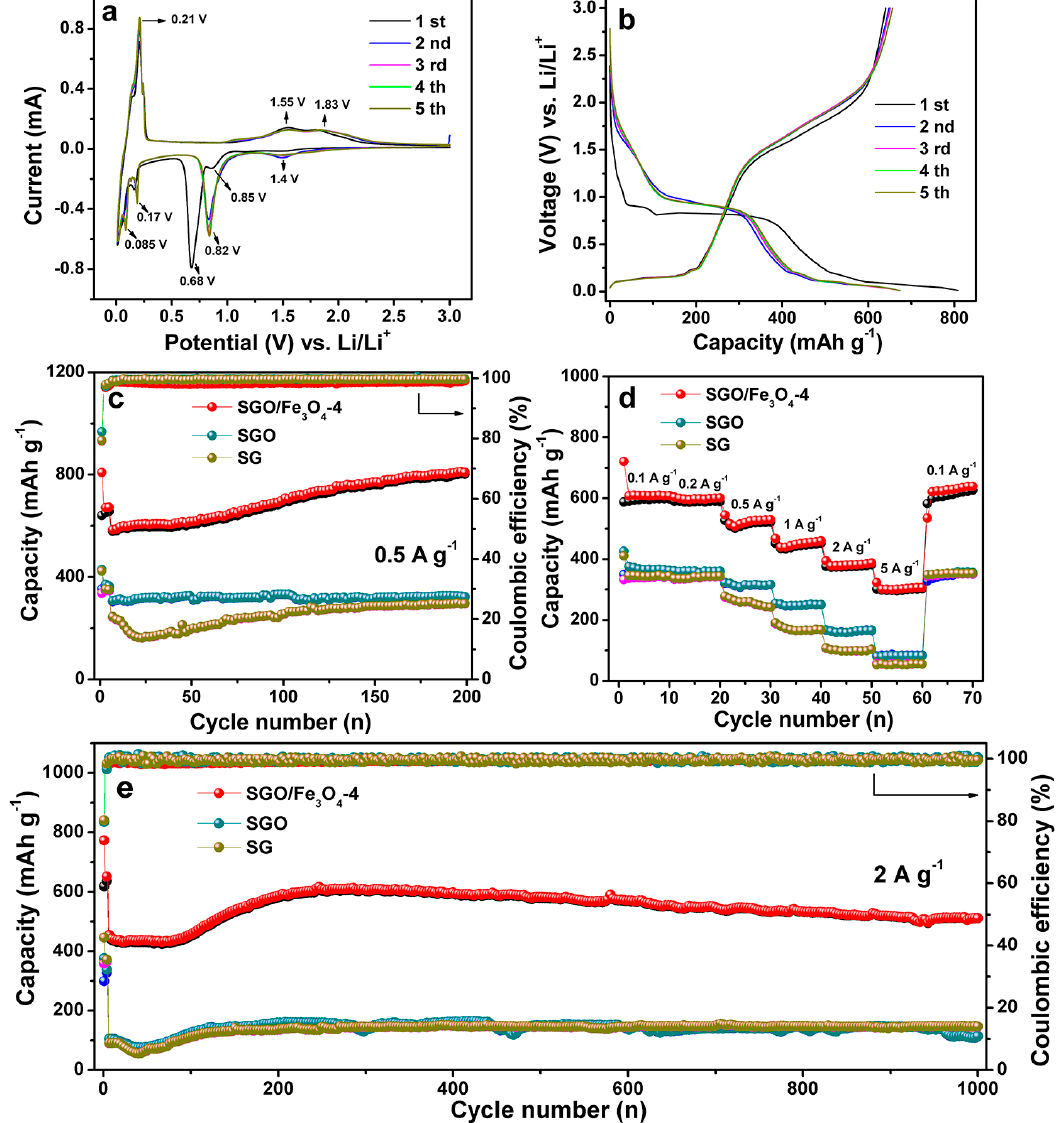
Figure 4. ( a ) CV curves of SGO/Fe 3 O 4 -4 at a scanning rate of 0.1 mV s − 1 . ( b ) Galvanostatic lithiation/delithiation curves of SGO/Fe 3 O 4 -4 at 0.1 A g − 1 . ( c ) Cycling performance at 0.5 A g − 1 for 200 lithiation / delithiation curves of SGO / Fe 3 O 4 -4 at 0.1 A g − 1 . ( c ) Cycling performance at 0.5 A g −